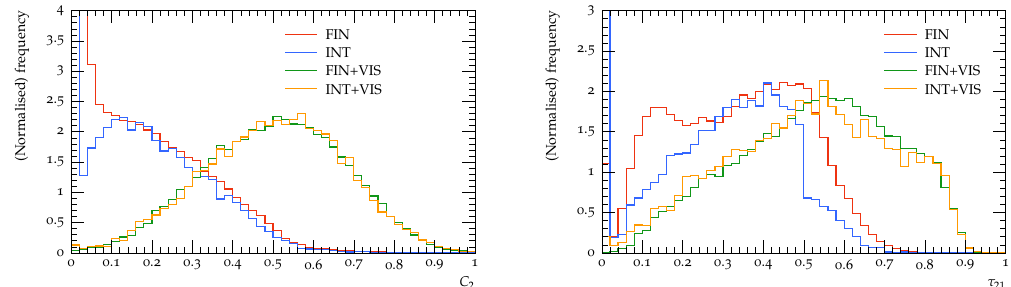
Figure 11: Comparisons of C (left) and τ (right) between different signals corre- 2 21 sponding to clustering only with final dark hadrons (FIN), intermediate dark hadrons (INT) and adding visible hadrons (VIS) in both cases. The entries at zero correspond to cases where the substructure variable could not be calculated, as only in rare cases the actual value of the observable was